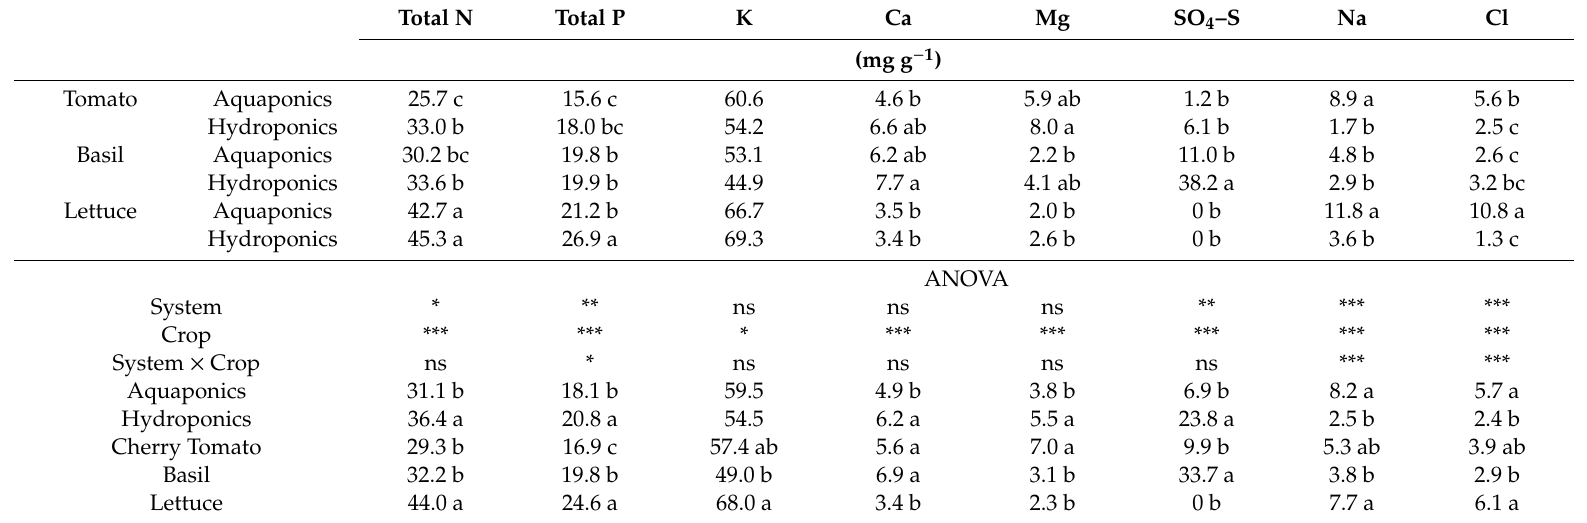
Table 8. Mineral nutrient concentrations in tomato, basil, and lettuce grown in aquaponic and hydroponic systems. Total N Total P K Ca Mg SO 4 –S Na